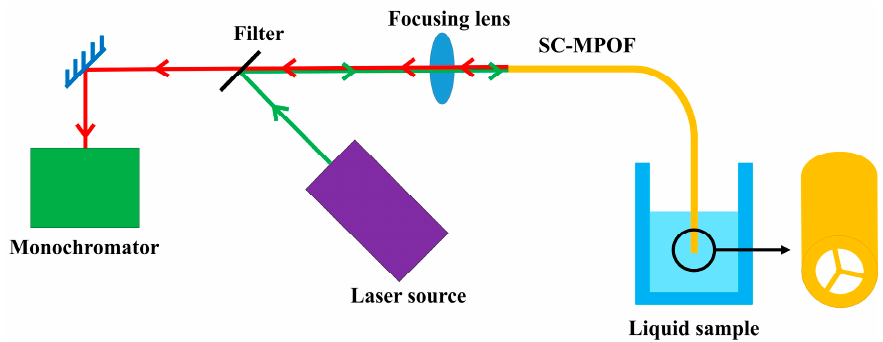
Figure 12. Configuration for SC-MPOF based fluorescence measurement using liquid dipping method.